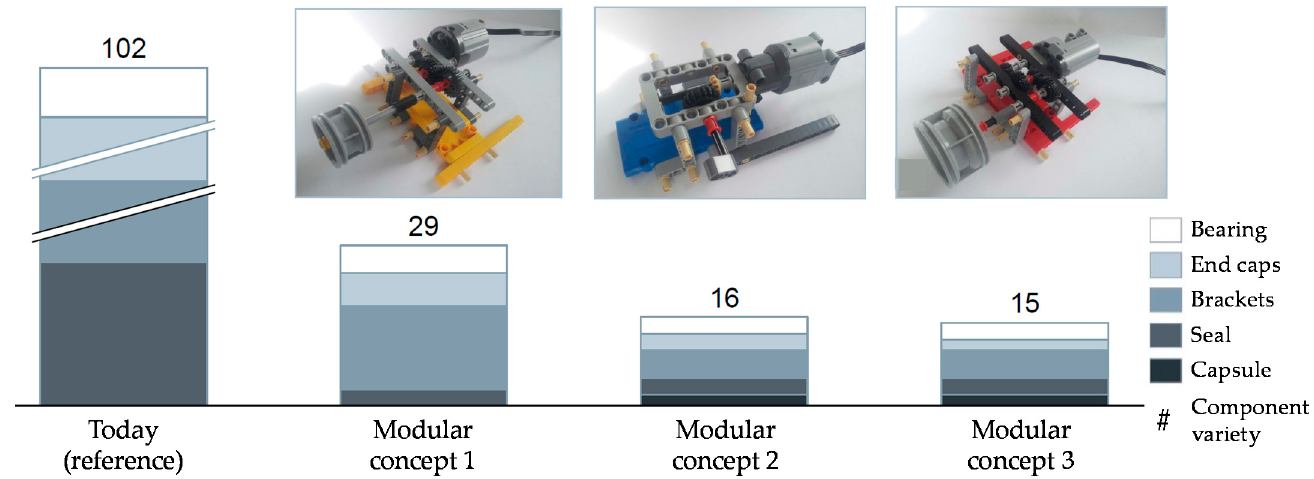
Figure 11. Comparison of the component variety of the developed modular concepts and the reference concept of the medium voltage electric motors (images for visualization only).